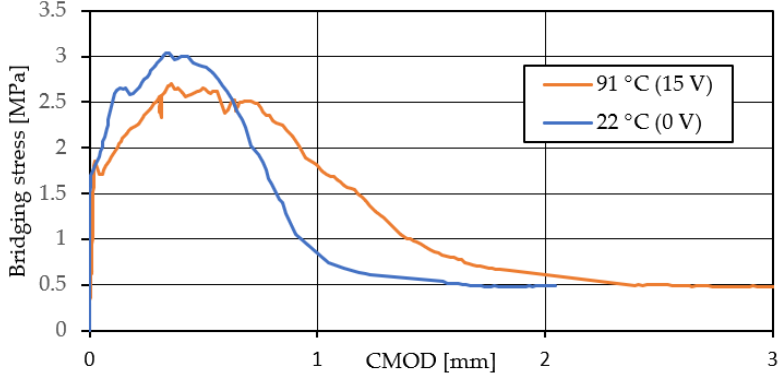
Figure 12. Effect of shrinkage behavior of TCPA on single cracked surface.